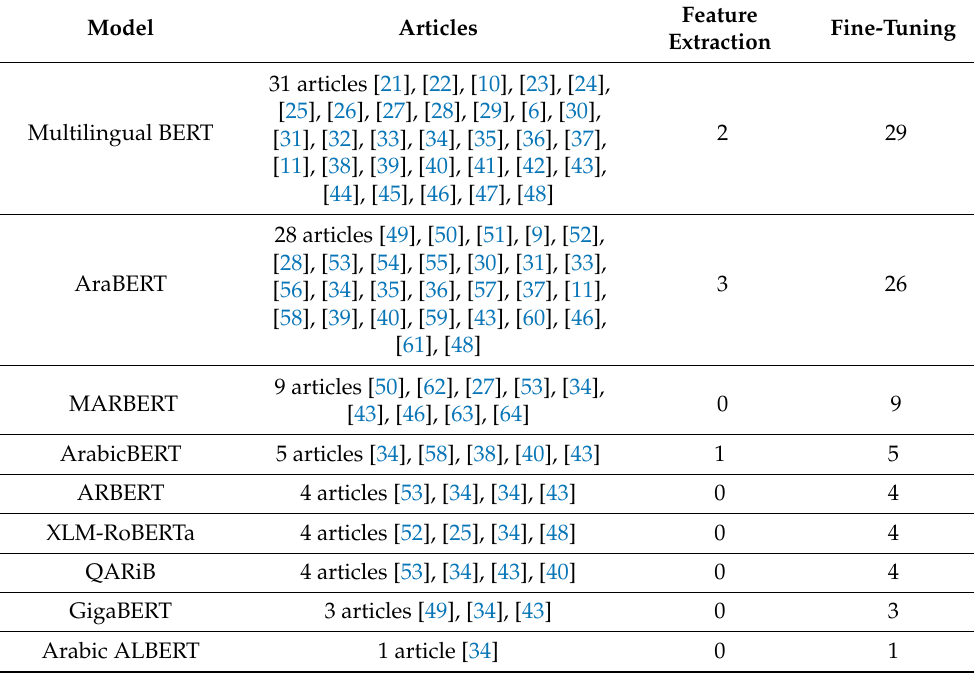
Table 4. Used BERT